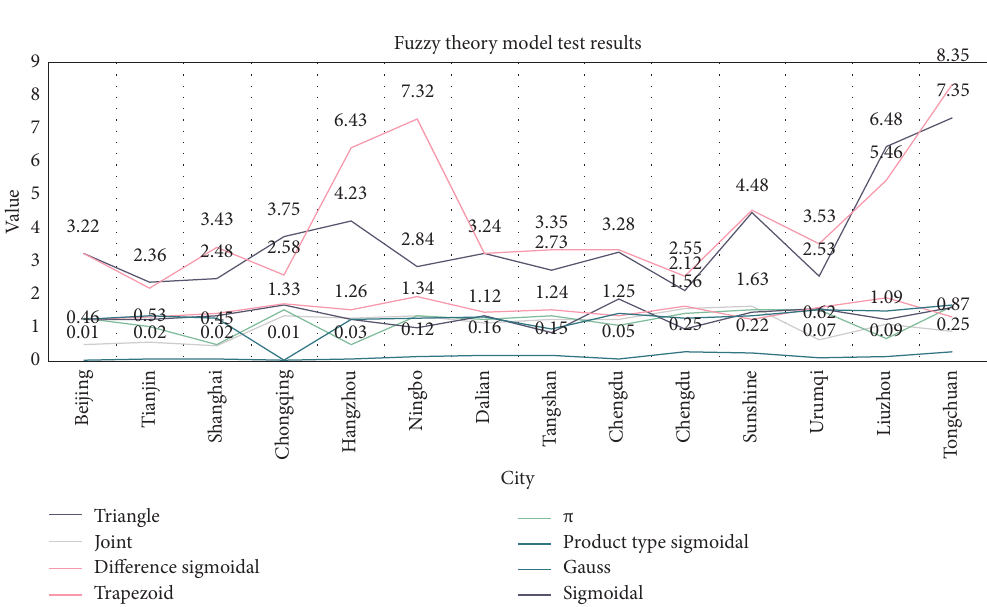
Figure 8: Fuzzy theory model test results.